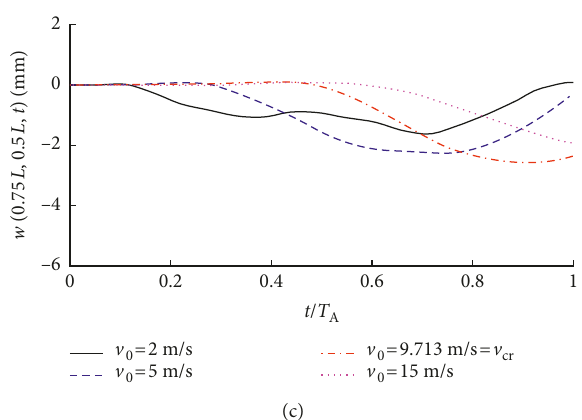
Figure 19: Effects of the moving speed v whose trajectory is given by Case 1 of (39), where v cr is the critical speed [5]. (a) At x